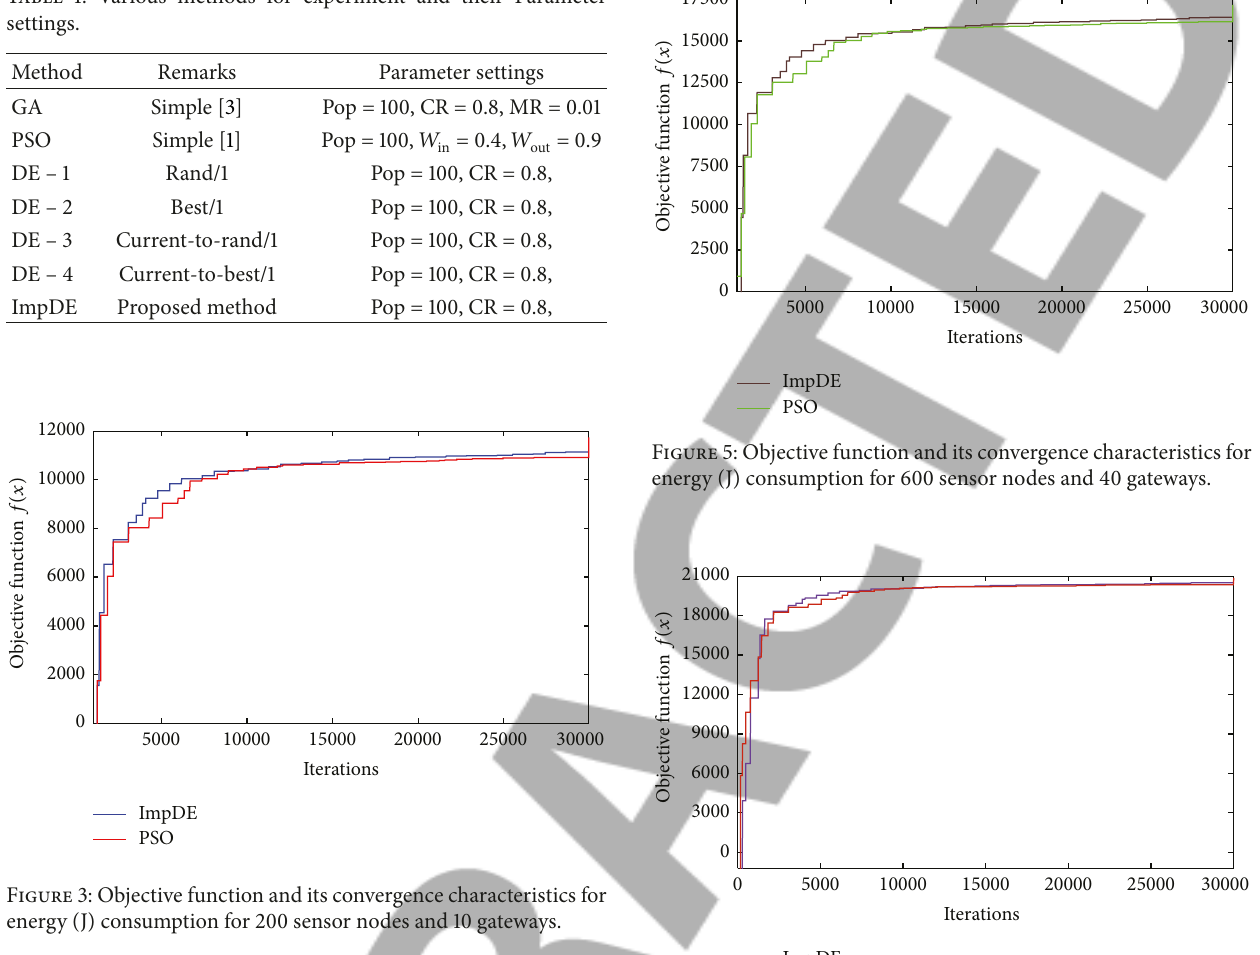
Figure 6: Objective function and its convergence characteristics for energy (J) consumption for 600 sensor nodes and 60